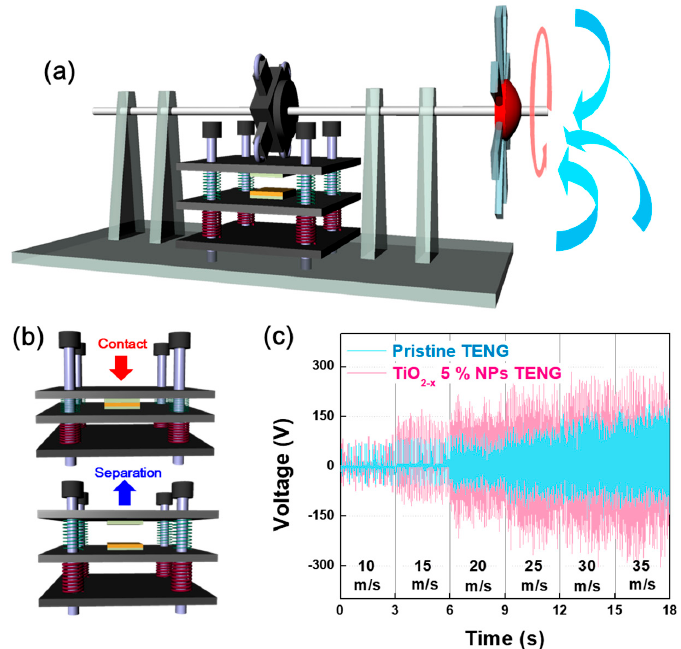
Figure 5. ( a ) Schematic of the windmill system and ( b ) TENG operation in the vertical direction repetitively switching between the contact and separation modes; ( c ) Measured voltage of the TiO 2 − x NPs 0% (pristine TENG) and 5% embedded TENG at different wind speeds applied to the windmill system.